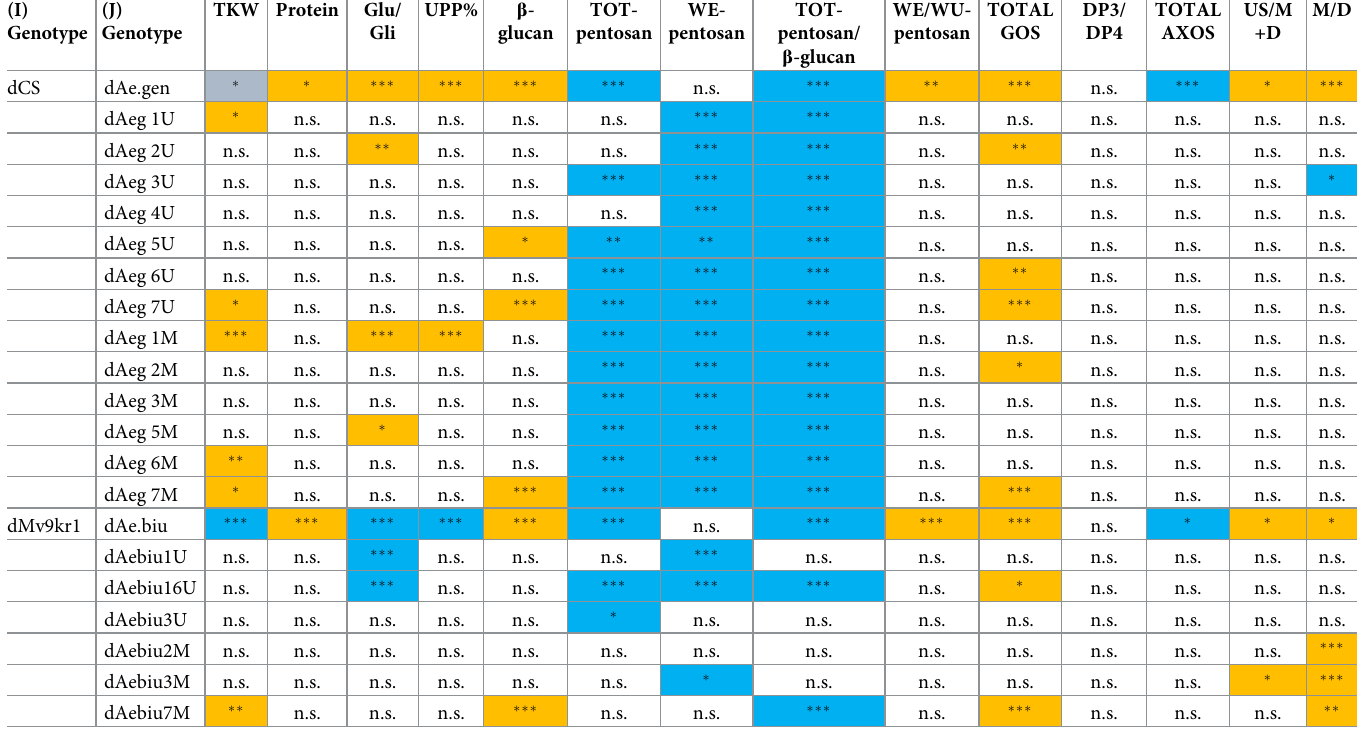
Table 3. Comparison of the effects of different chromosomes in a wheat ( T . aestivum ) genetic background under drought conditions using the Post Hoc multiple pairwise comparison test. Orange and blue blocks indicate values higher and lower than the control, respectively. (I) (J) Genotype